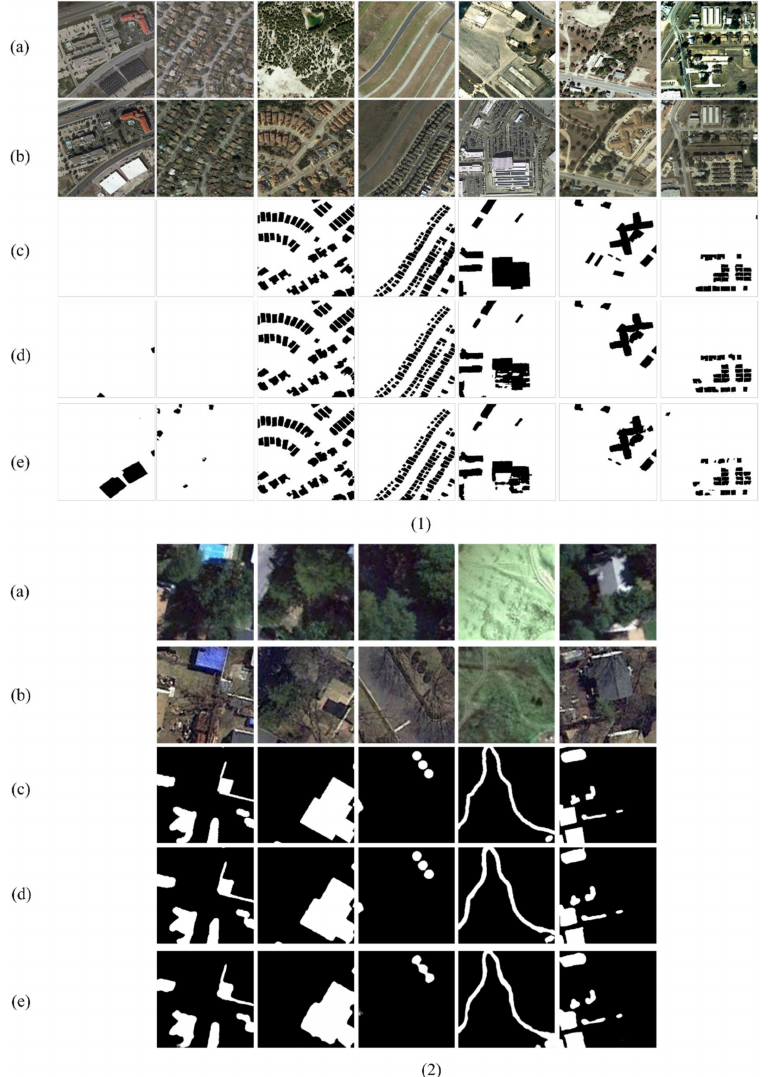
Figure 6. CD results of 3M-CDNet and that of w/o DConv on the LEVIR-CD dataset ( 1 ) and the Season-Varying dataset ( 2 ). Zoom in for an improved view. ( a ) Image T1. ( b ) Image T2. ( c ) Reference change map. ( d ) 3M-CDNet. ( e ) w/o